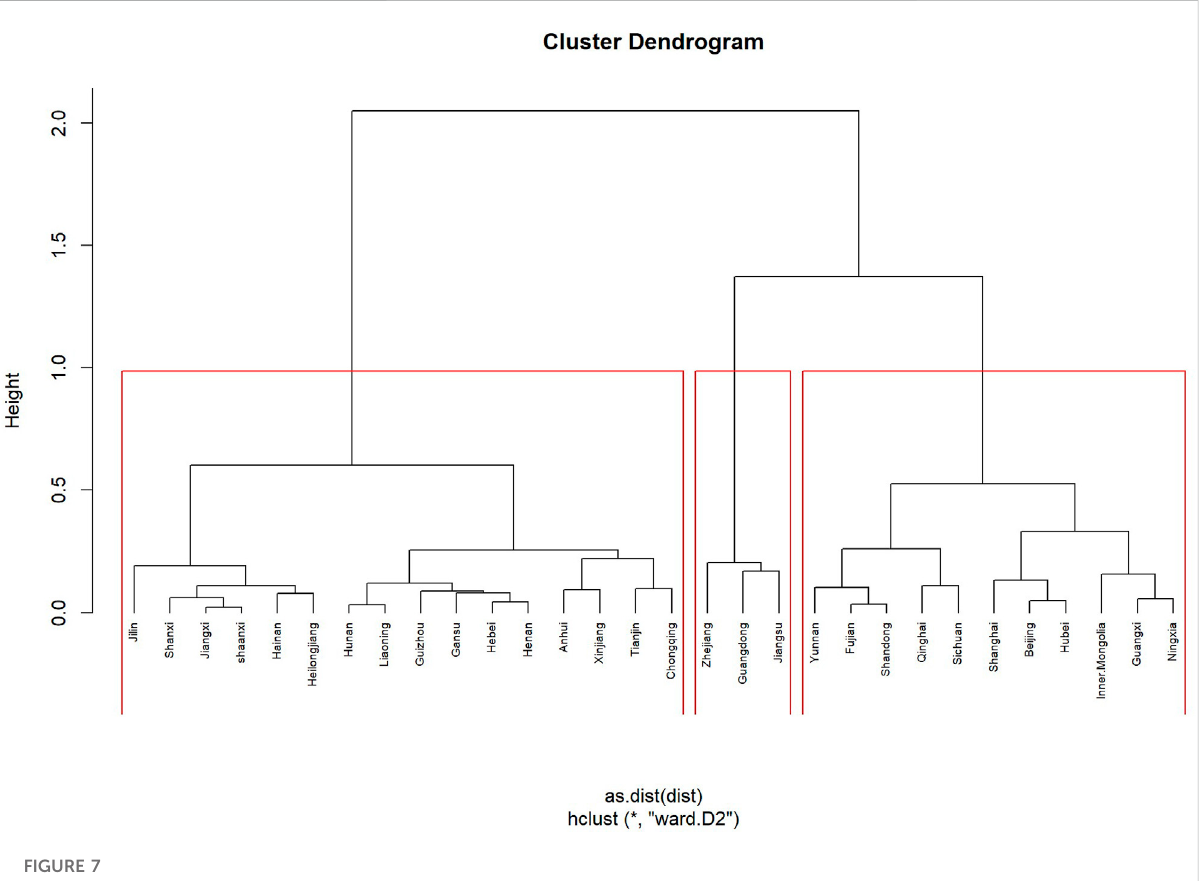
FIGURE 7 Cluster dendrogram of the re-electri fi cation index.